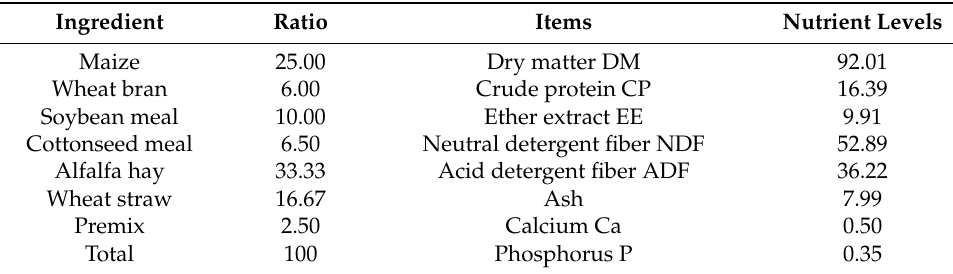
Table 1. Diet composition and nutrient levels